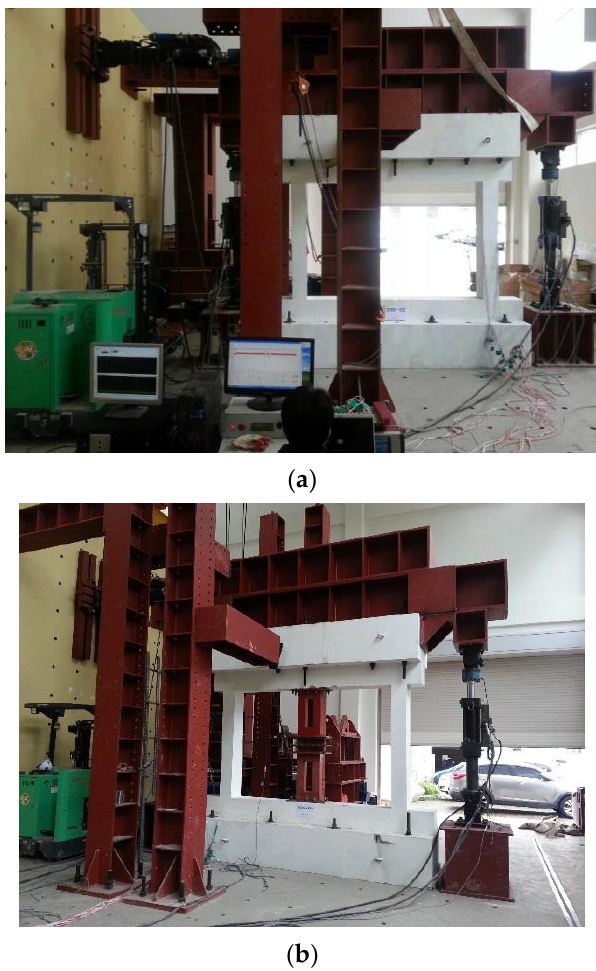
Figure 9. Test set-up. ( a ) without WKDS, ( b ) with WKDS.